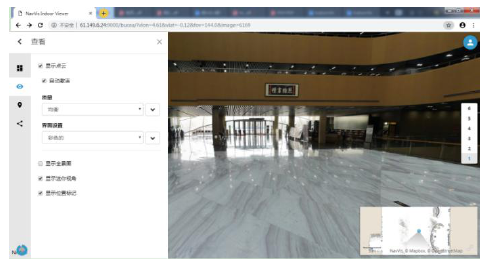
Figure 9. Interest Point Editing Interface